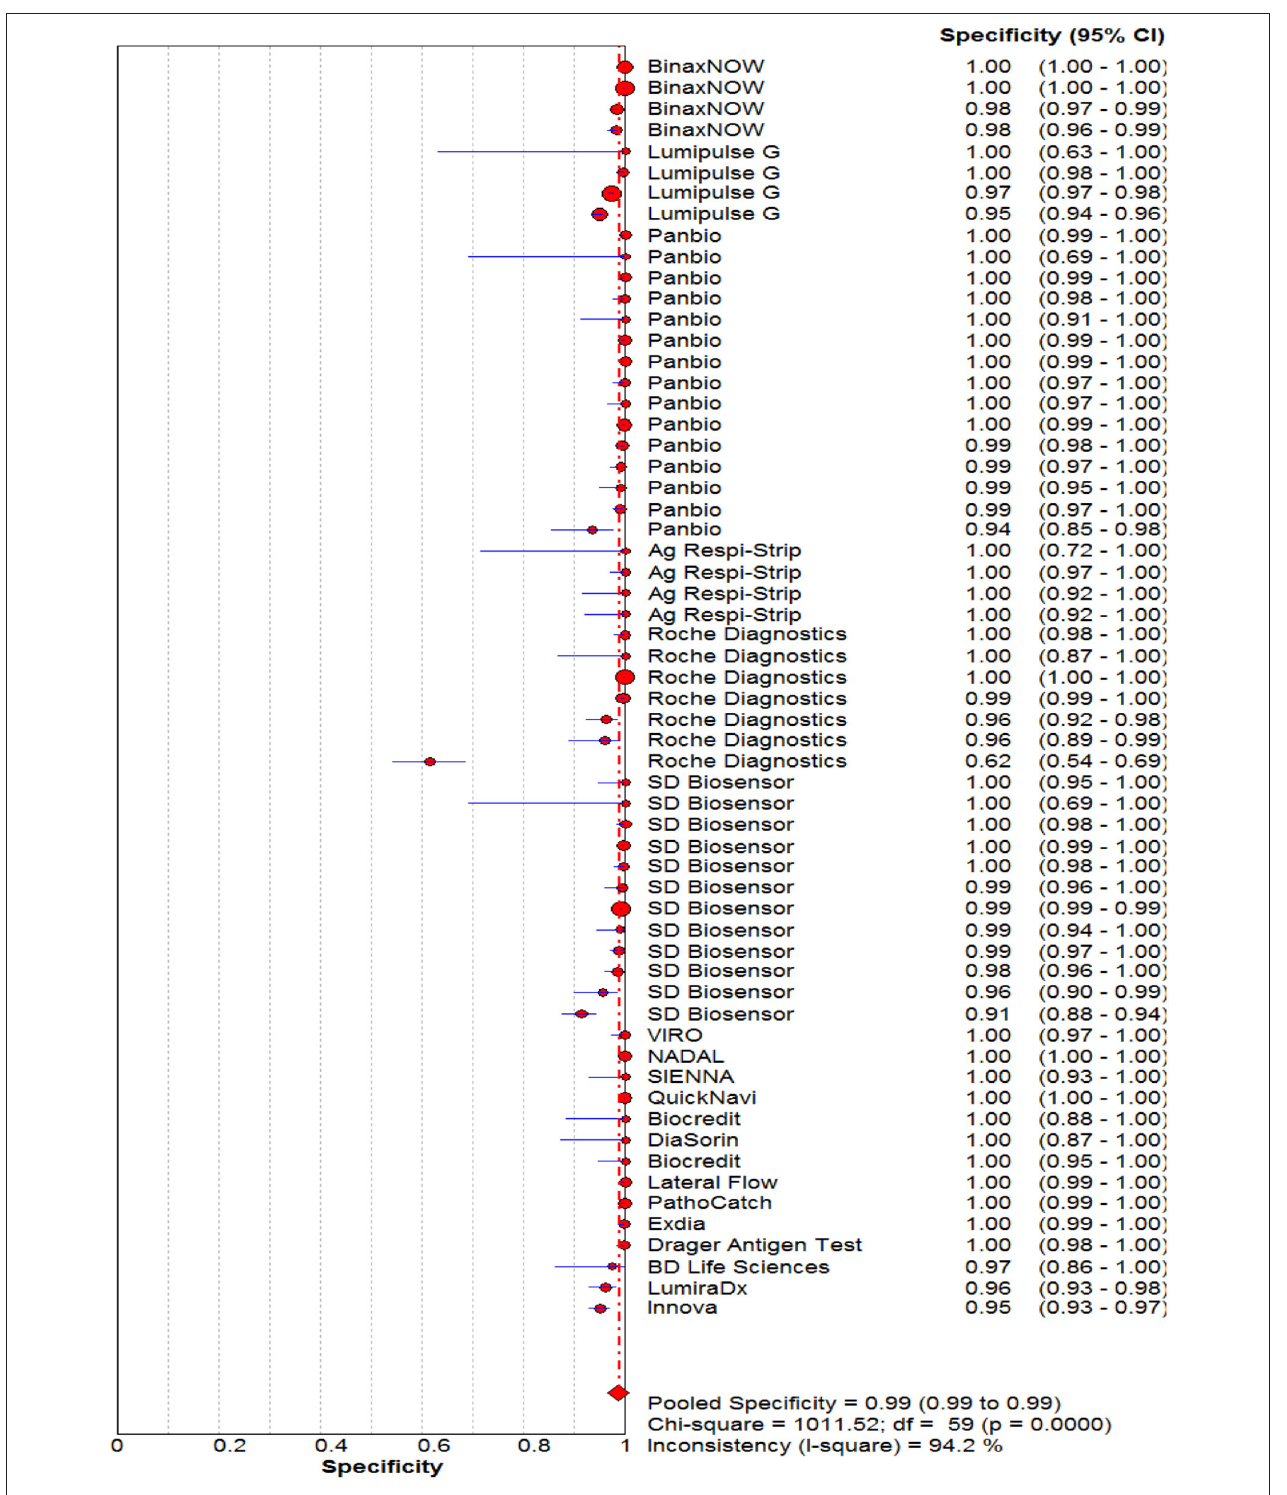
FIGURE 3 | Forest plot of pooled specificity of rapid antigen tests for the diagnosis of COVID-19. The point estimates of specificity from each study are indicated as a circle and a 95% confidence interval is shown with a horizontal line.